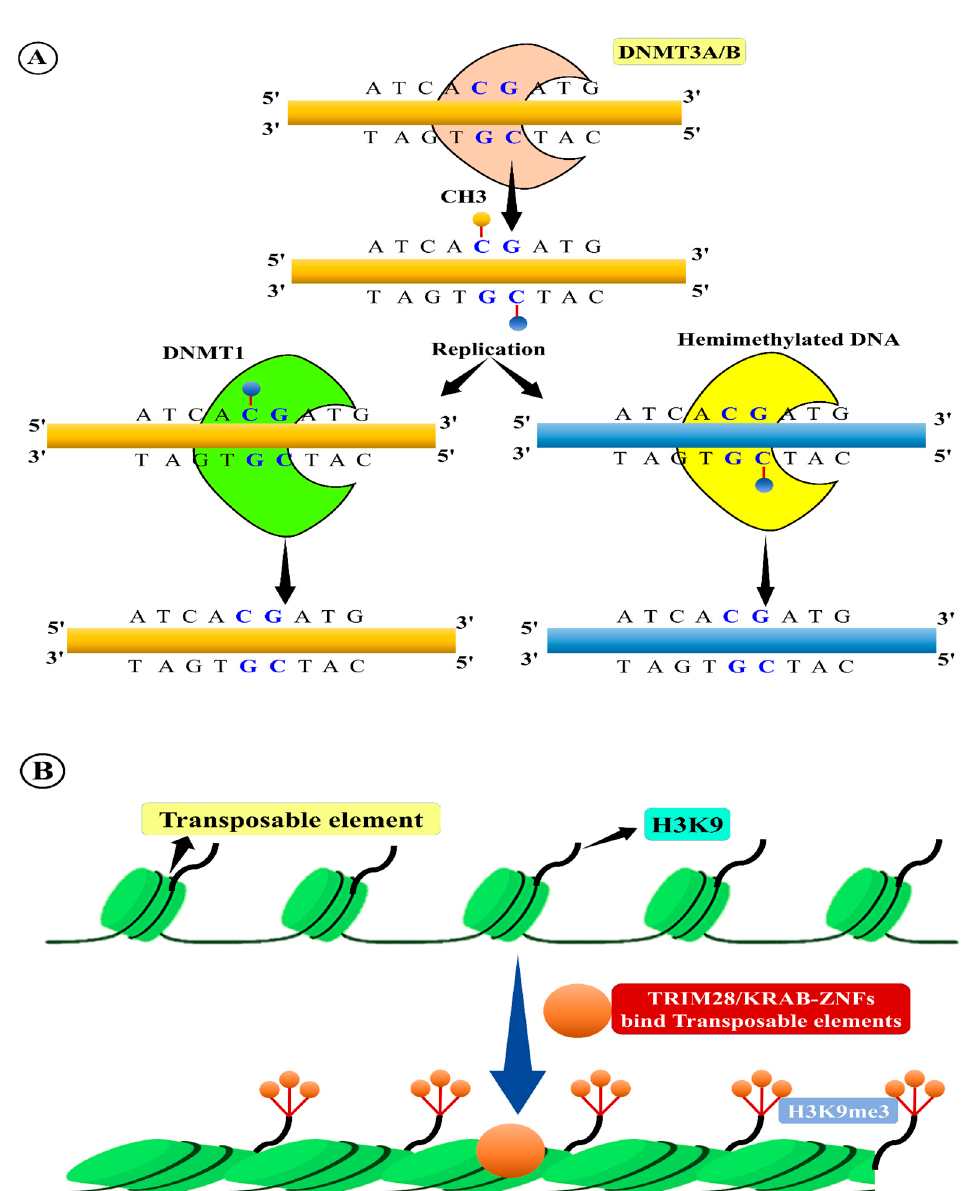
Figure 4. Transposable elements (TEs) are suppressed by DNA and histone methylations. ( A ) TE methylation is most commonly found in the CG context. The de novo DNA methylation is performed by DNA methyltransferases DNMT3A and 3B; the pattern of DNA methylation is maintained by DNMT1 by adding a methyl group to the newly synthesized DNA strand (a complementary strand of the hemi-methylated DNA strand), thus ensuring that the epigenetic modifications are inherited by the daughter cell. ( B ) Nucleosomes are made up of DNA and eight histone proteins. These proteins can be modified in several ways for chromatin accessibility, thereby either activating or inactivating gene expression (gene imprinting). TRIM28, a silencing complex, recognizes KRAB-ZNFs (Kruppel-associated box zinc-finger proteins), which contain a TE-binding domain and deposits H3K9me3 on TE (euchromatin region), thus causing TE repression and heterochromatin formation. The illustration was adapted and redrawn from Jönsson et al. [43], with copyright permission from the Licensor Elsevier (Trends in Genetics: Cell Press publisher) and Copyright Clearance Center (https: //www.copyright.com) (Supplementary File